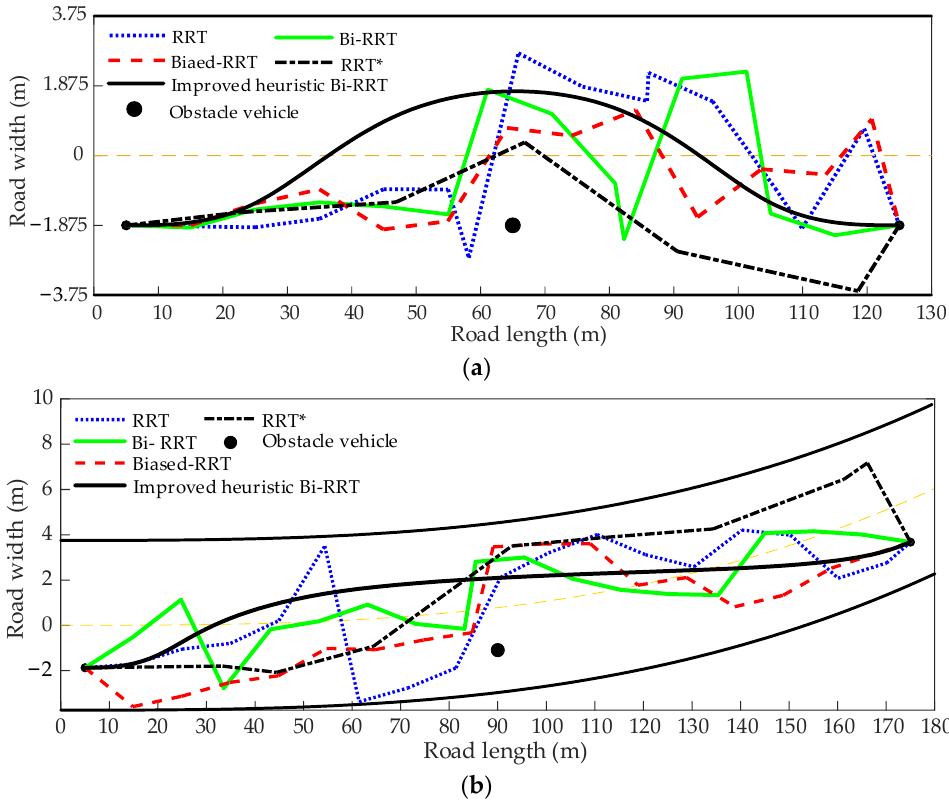
Figure 14. The simulation paths. ( a ) The planned paths in the straight road scenario. ( b ) The planned paths in the curved road scenario.